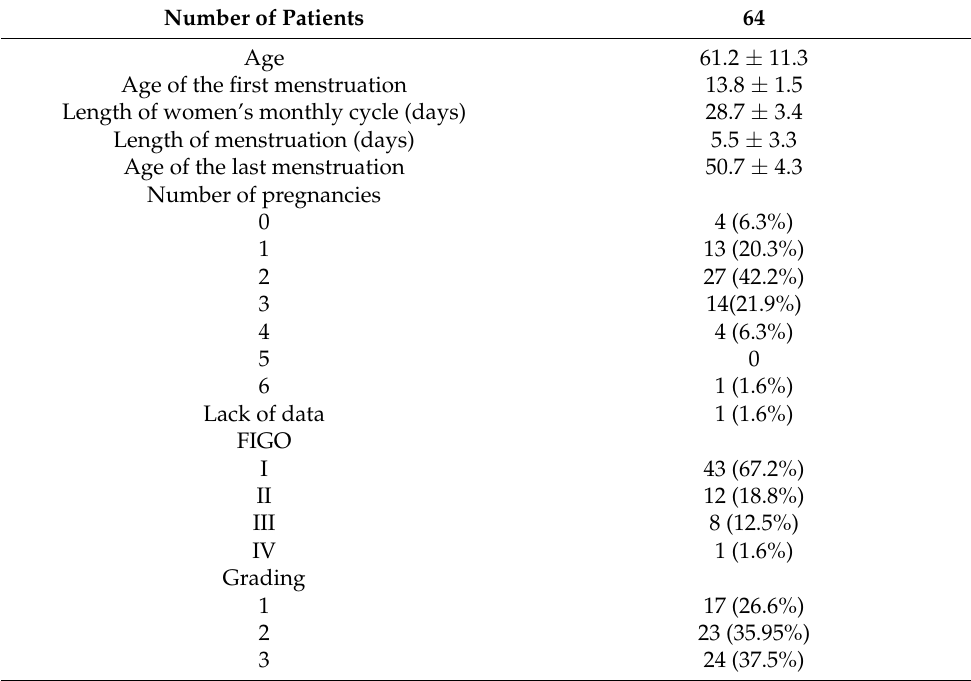
Table 1. Characteristics of the patients and endometrial carcinoma staging.